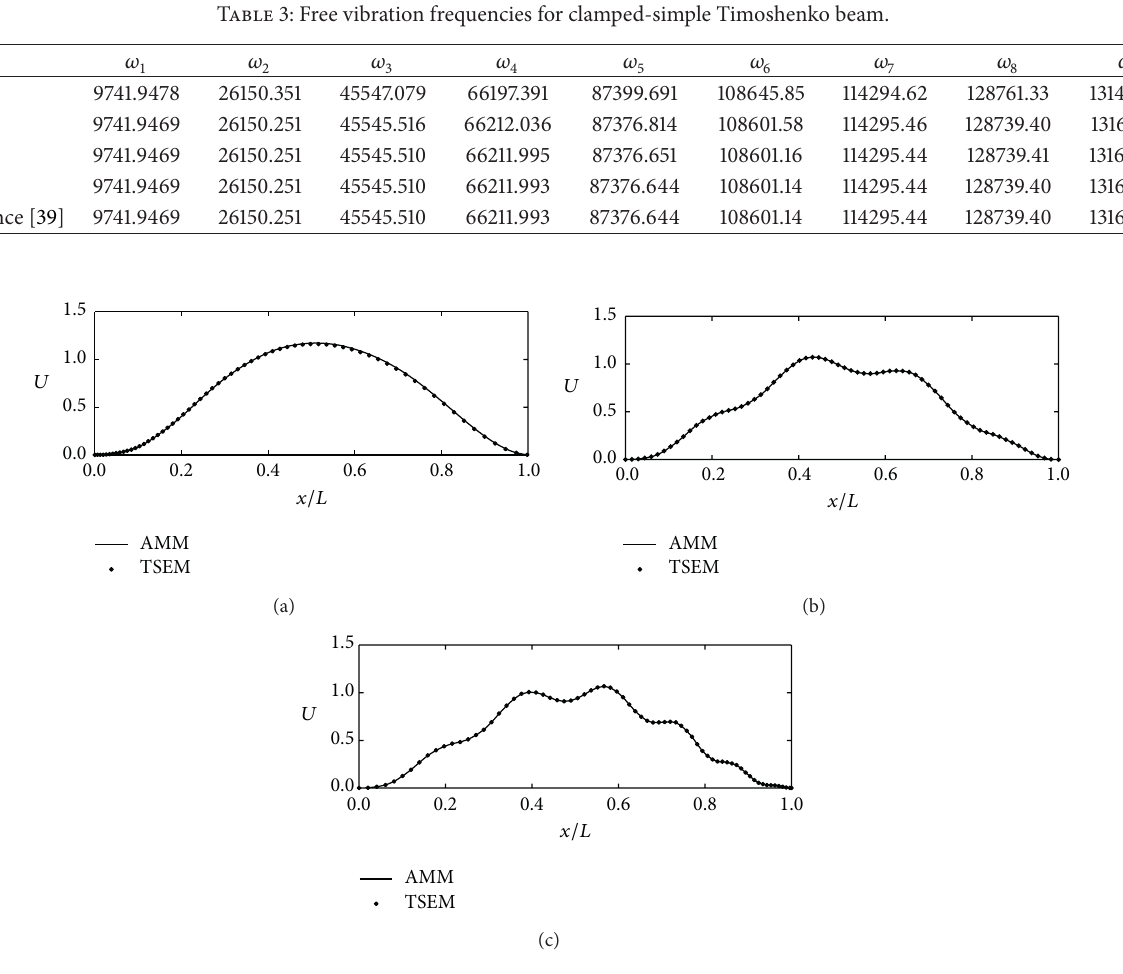
Figure 3: Normalized displacement under the equivalent moving loads with the initial speed given by 𝜏 = 0.11 . 𝛽 = 0.03 . (a) 𝜆 = 1 , (b) 𝜆 = 0 , and (c) 𝜆 = −0.05